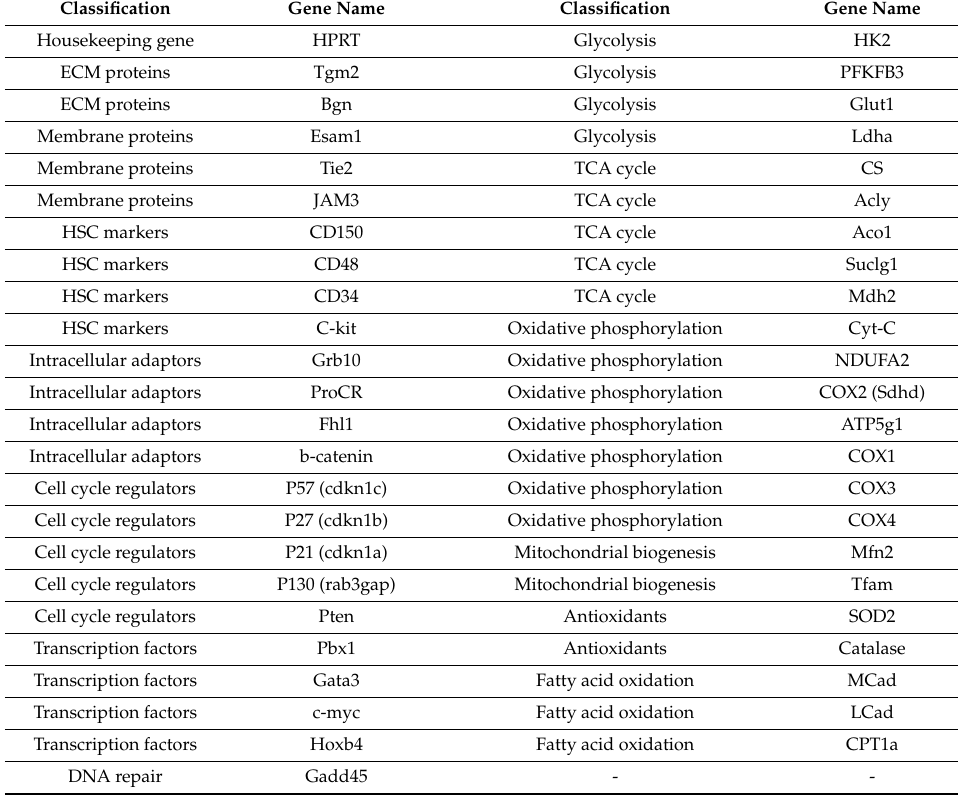
Table 1. List of genes tested in single-cell multigene expression